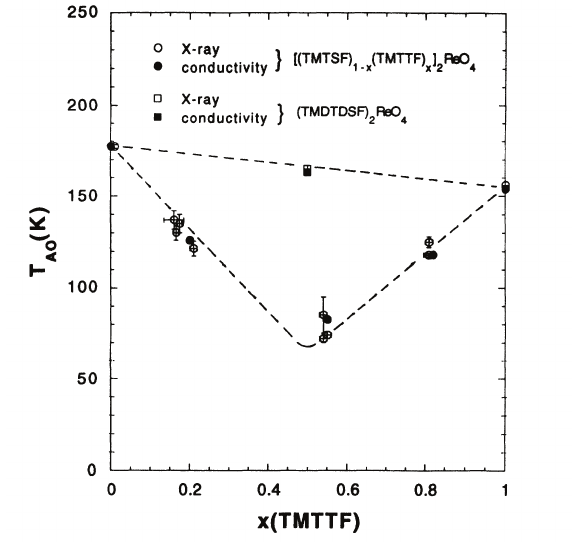
Figure 7. Anion ordering critical temperature for the ReO 4 salt in different families of organic conductors and their alloys. After Ilakovac et al. [26] and references there